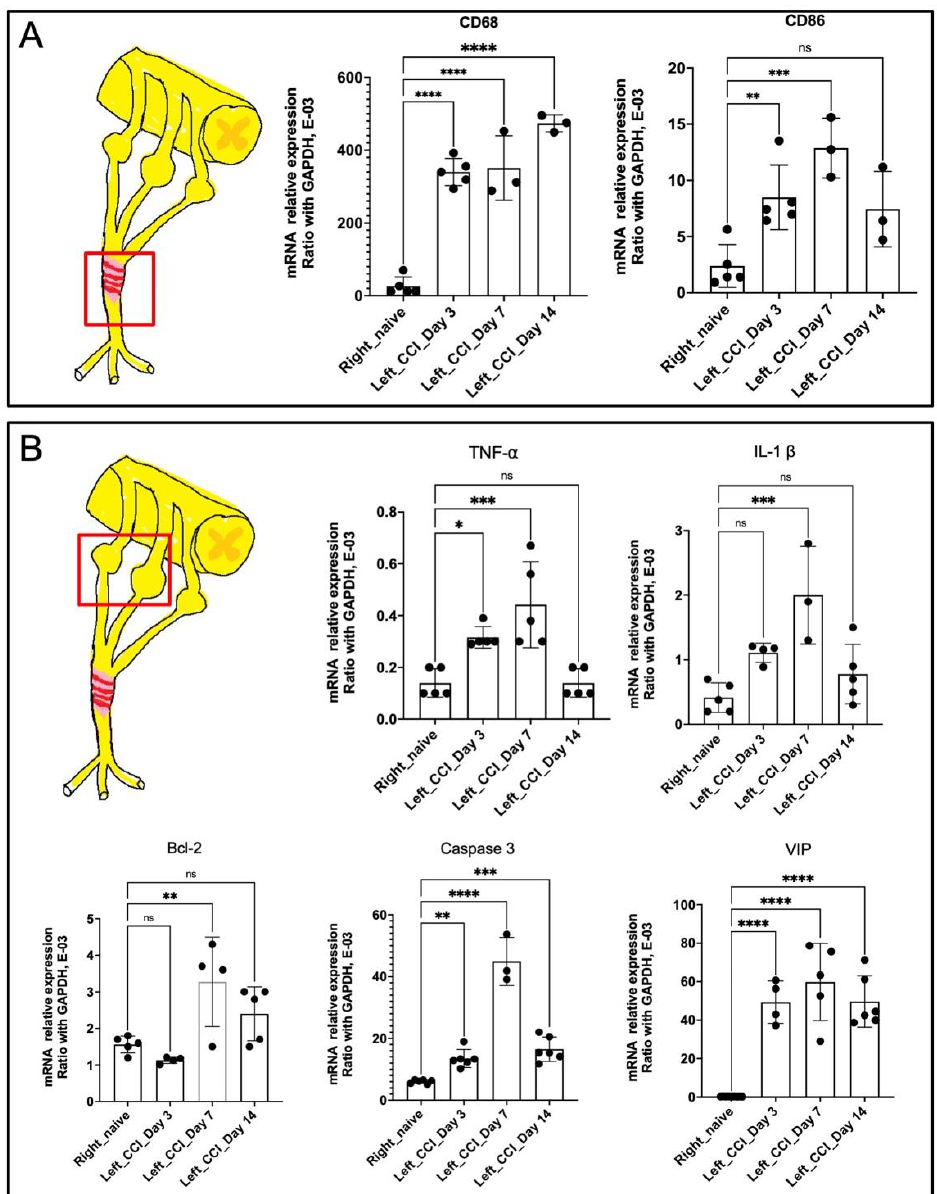
Figure 5. Quantitative PCR analysis of inflammatory gene among injured nerve and dorsal root ganglion. ( A ) Upregulation of CD68 and CD86 expression over injured nerve at post nerve release day 3, 7 and 14, as compared to uninjured nerve. ( B ) Upregulation of TNF- α , IL-1 β , BCL-2, Caspase 3 and VIP expression over injured DRG at post nerve release day 3, 7 and 14, as compared to uninjured side. (Data was presented with mean ± standard deviation, * indicated p < 0.05; ** indicated p < 0.01, *** indicated p < 0.001, **** indicated p < 0.00001, ns indicated no significant dif- ference).